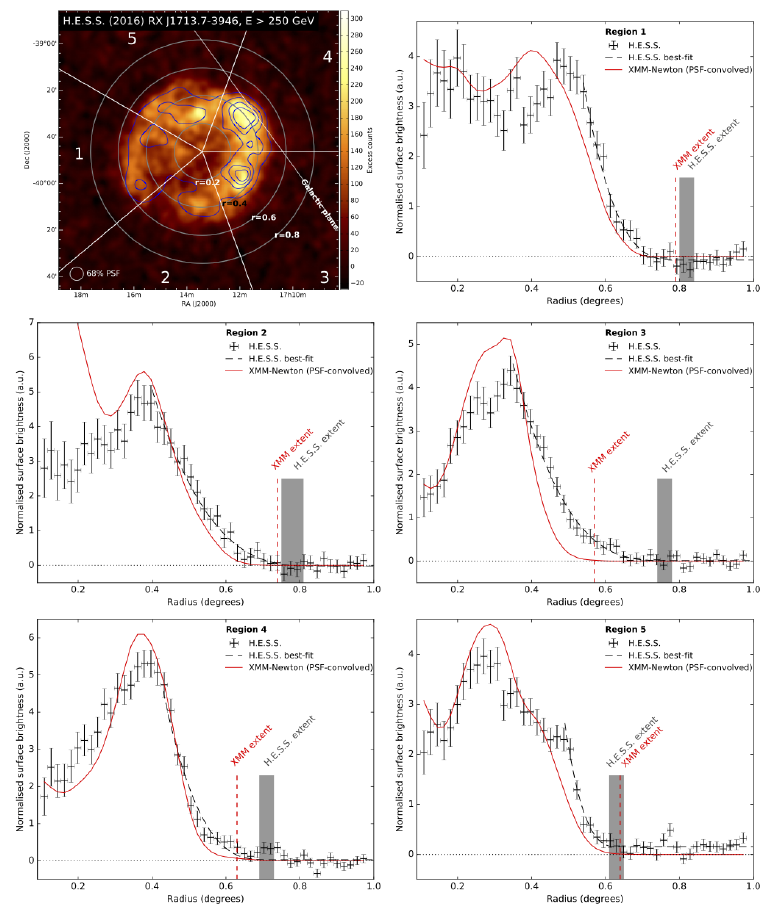
Figure 1. The VHE gamma-ray excess map and radial profiles of RX J1713.7-3946 above 250GeV obtained from 170 h observations by the H.E.S.S.s telescope are shown [18]. Top left: the High Energy Stereoscopic System (H.E.S.S.) gamma-ray count map (E > 250GeV) is shown with XMMs X-ray contours (1-10keV, smoothed with the H.E.S.S. PSF) overlaid. The five regions used to compare the gamma-ray and X-ray data are indicated along with concentric circles (dashed grey lines) with radii of 0.2 ◦ to 0.8 ◦ and centered at the SN location. The radial profiles of region 1 to region 5 are shown in the top right panel, and in the middle and bottom panels. Black crosses correspond to the TeV profiles extracted from the H.E.S.S. map. The red lines are X-ray profiles extracted from the XMM map convolved with the H.E.S.S. PSF. The relative normalization between the H.E.S.S.s and XMMs profiles is chosen such that for regions 1, 2, and 4, the integral in [0.3 ◦ , 0.7 ◦ ] is the same for regions 3 and 5 in [0.2 ◦ , 0.7 ◦ ]. The grey shaded area shows the combined statistical and systematic uncertainty band of the radial gamma-ray extension. The vertical dashed red line is the radial X-ray